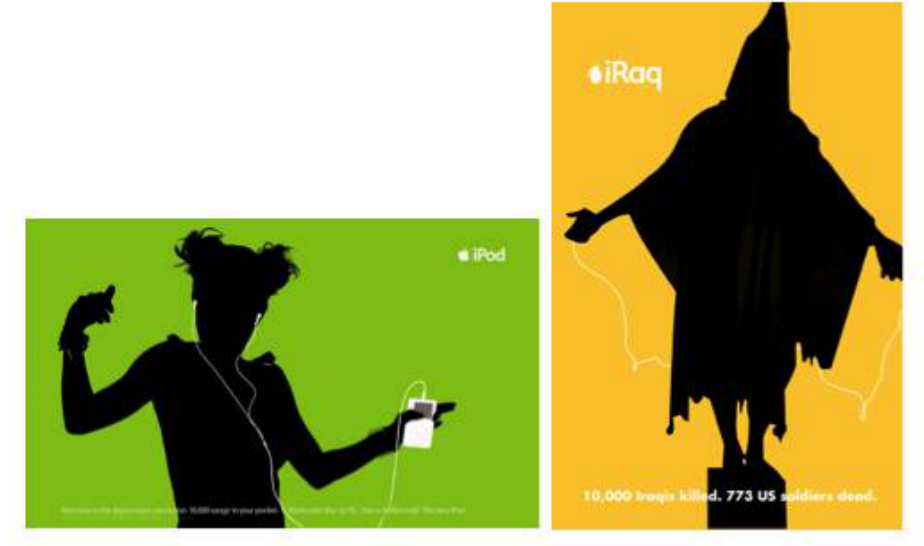
Figure 5. Advertisement and parody. ( left ) Susan Alinsangan, Lee Clow, James Vincent, Chiat/Day. iPod advertisement campaign (2003); ( right ) Forkscrew. iRaq [Abu Ghraib Prisoner] , silkscreen